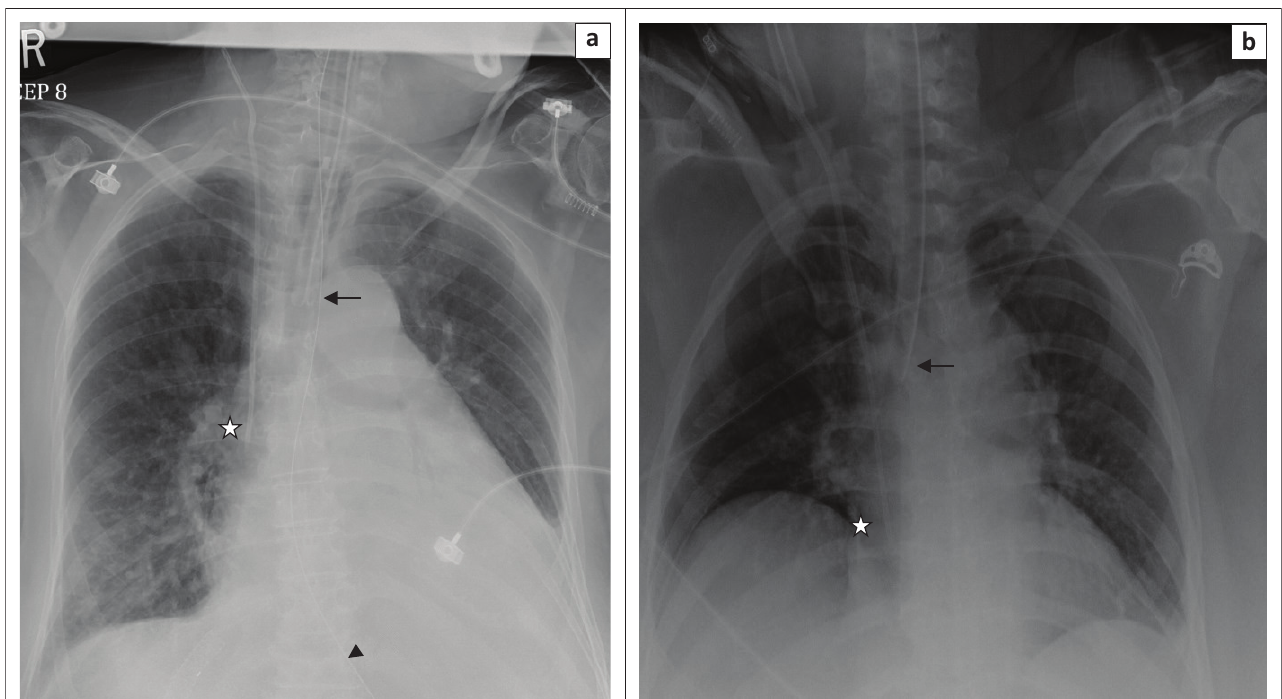
FIGURE 1: (a) Magnified chest radiograph showing an accurately placed endotracheal tube with its distal end (arrow) located above the carina. Other lines and tubes visualised are the right internal jugular vein central venous catheter (star) and the nasogastric tube (arrow head); (b) chest radiograph showing a malpositioned endotracheal tube with its tip in the right main bronchus (arrow). A central venous catheter is noted in the right atrium (star).